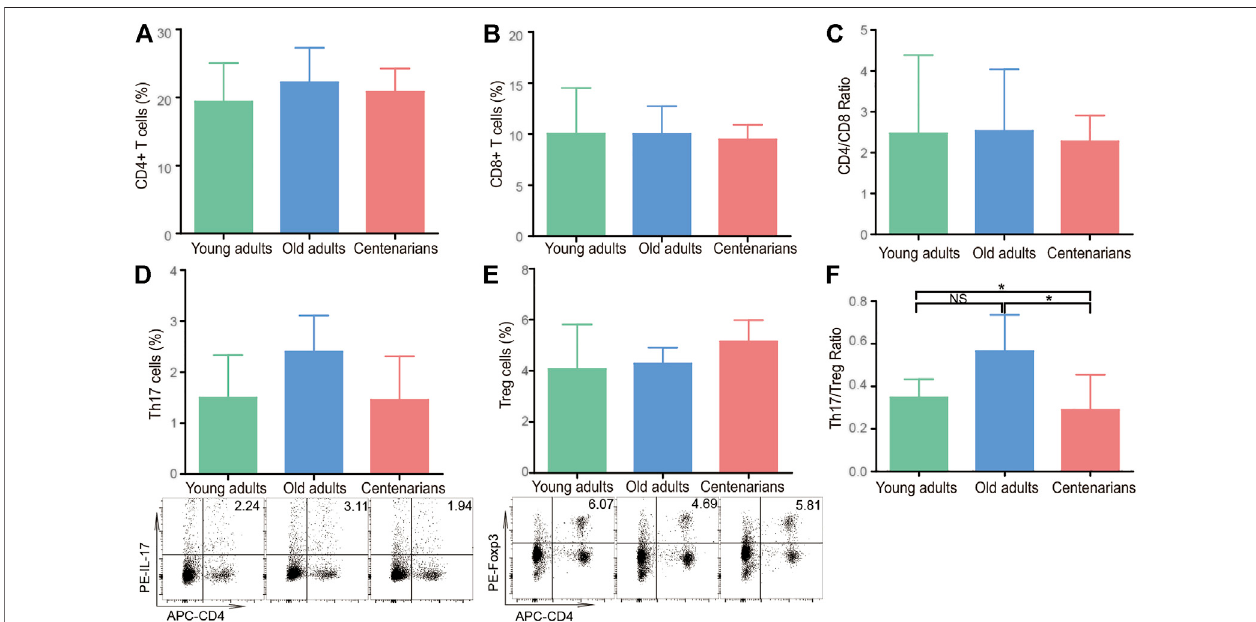
FIGURE 2 | The Th17/Treg cell ratio decreased in centenarians. PBMCs were extracted from young adults, old adults and centenarians. CD4 + T cells (A) , CD8 + T cells (B) , and the ratio of CD4 + /CD8 + cells (C) were analyzed by FCM. Th17 cells (D) and Treg cells (E) and the ratio of Th17/Treg cells (F) were analyzed. Data were expressed as the mean ± SD. n = 8. Asterisks (*) indicate signi fi cant differences (* p < 0.05; ** p < 0.01); NS, not signi fi